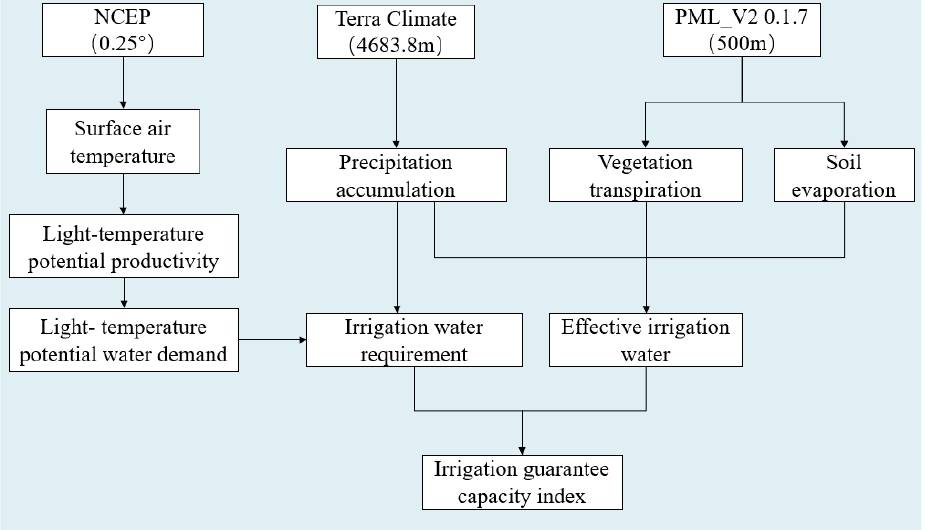
Figure 2. The framework for computing IGCI based on the GEE platform.